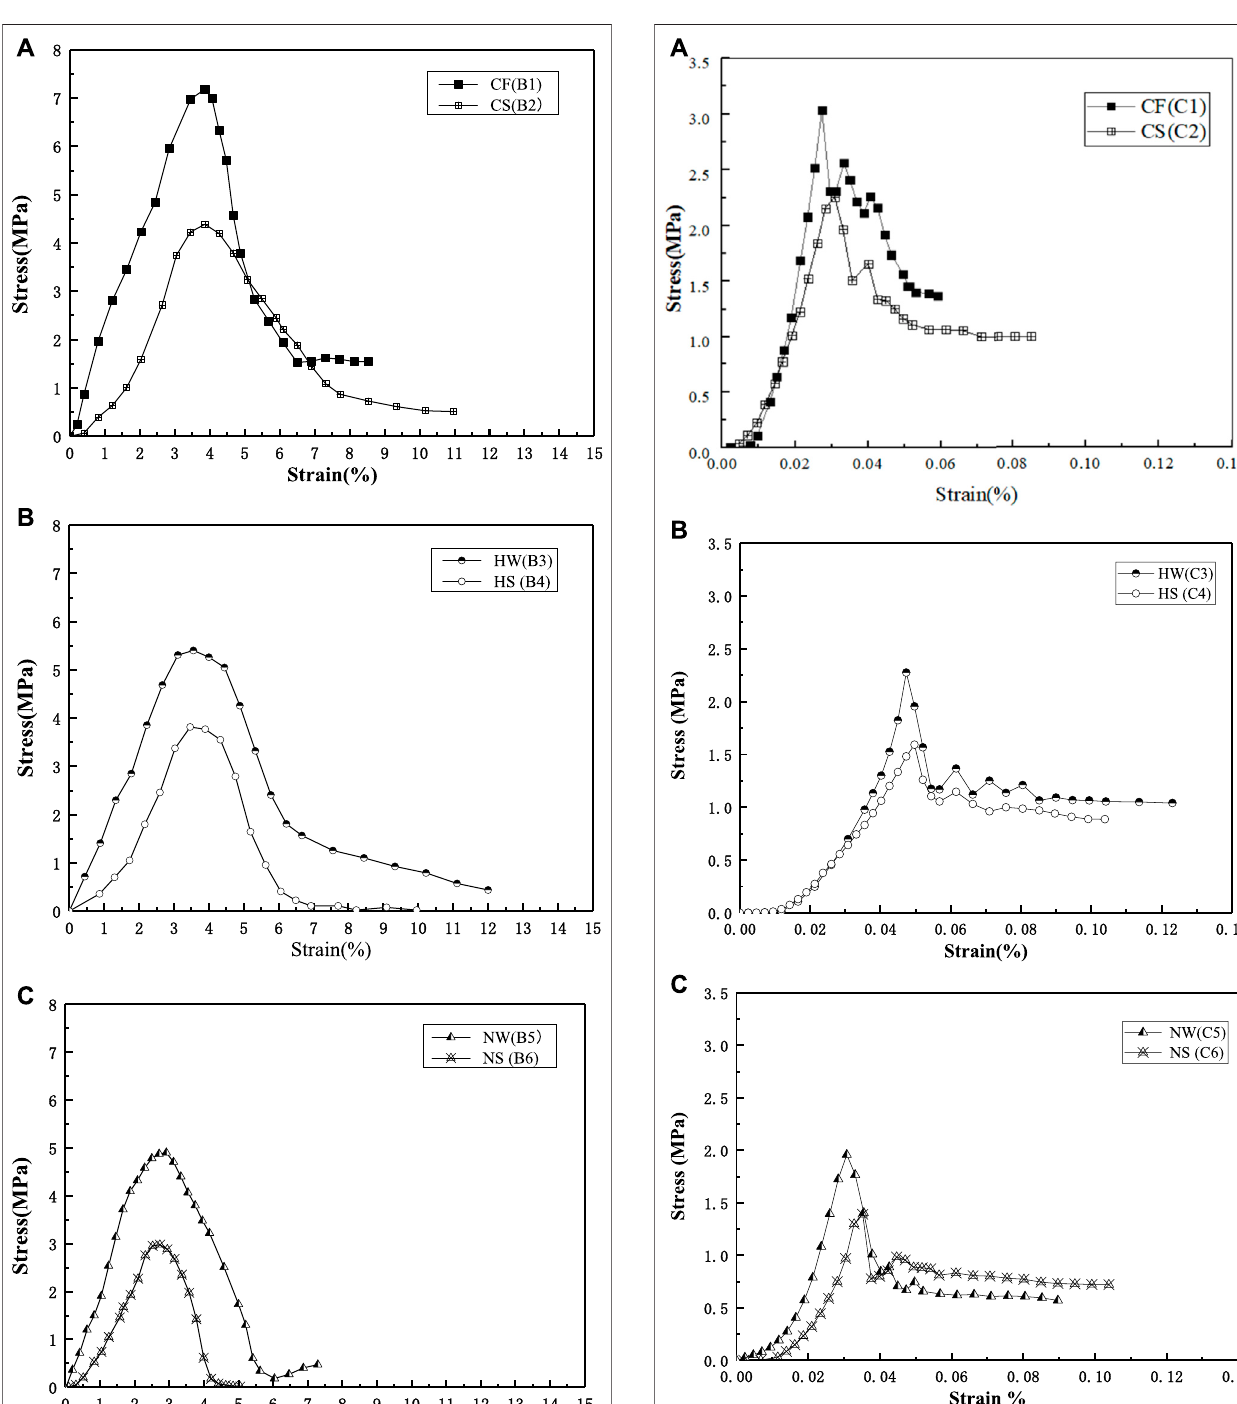
were soaked in a 0.5 M cementation solution in glass beakers,